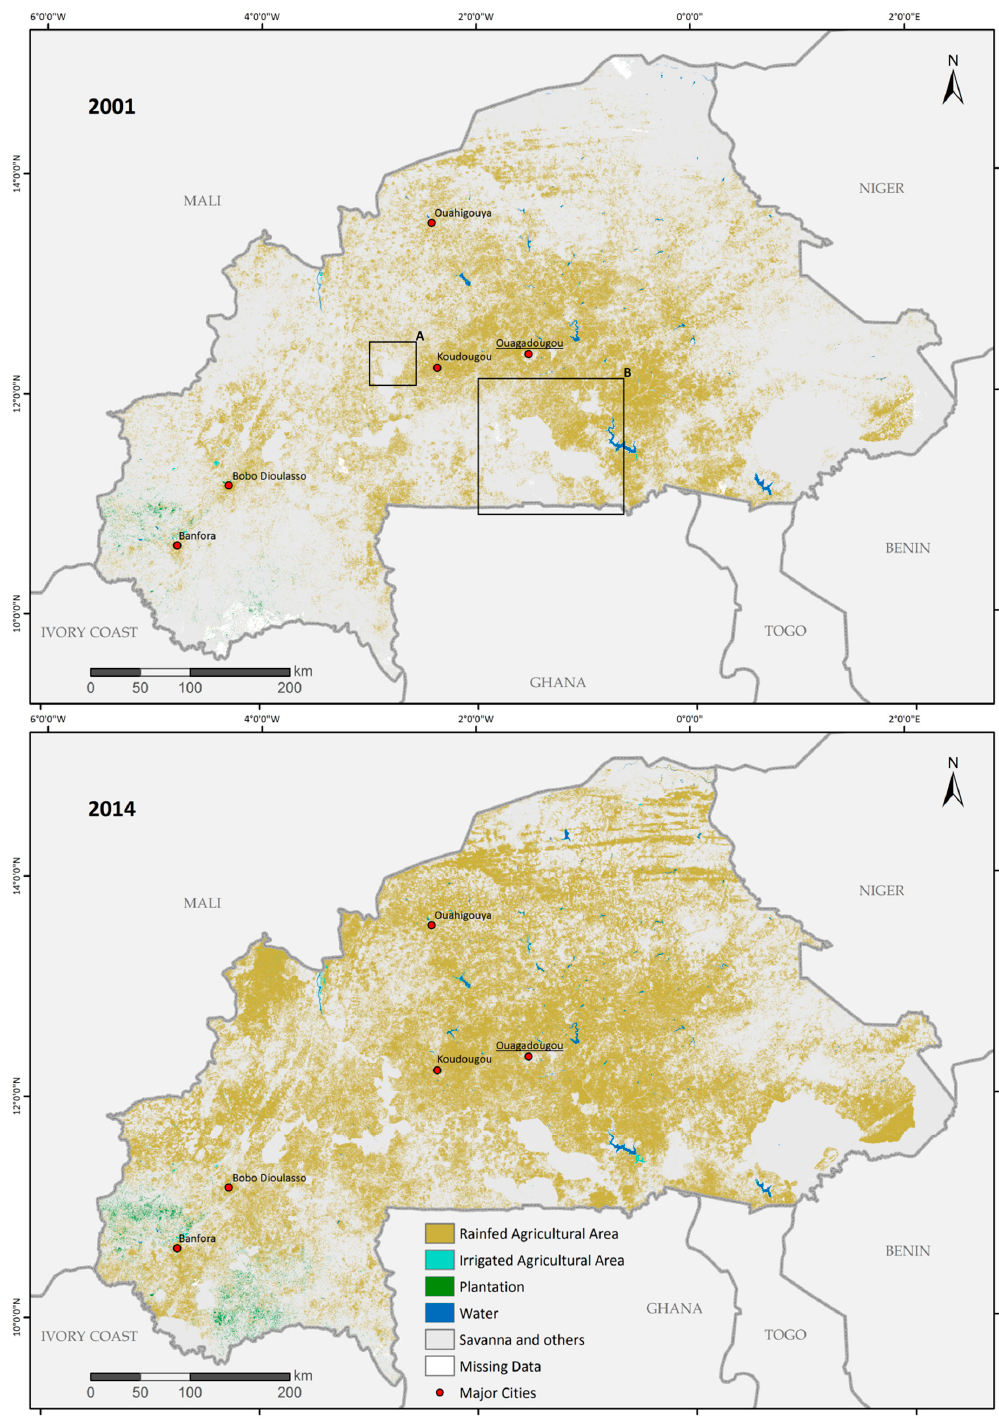
Figure 3. Extent of agricultural area of Burkina Faso for the years 2001 ( top ) and 2014 ( bottom ). Framed areas mark the locations of the focus sites of Section 4.4, the Tiogo classified forest (A) and the Kaboré Tambi National Park (B).